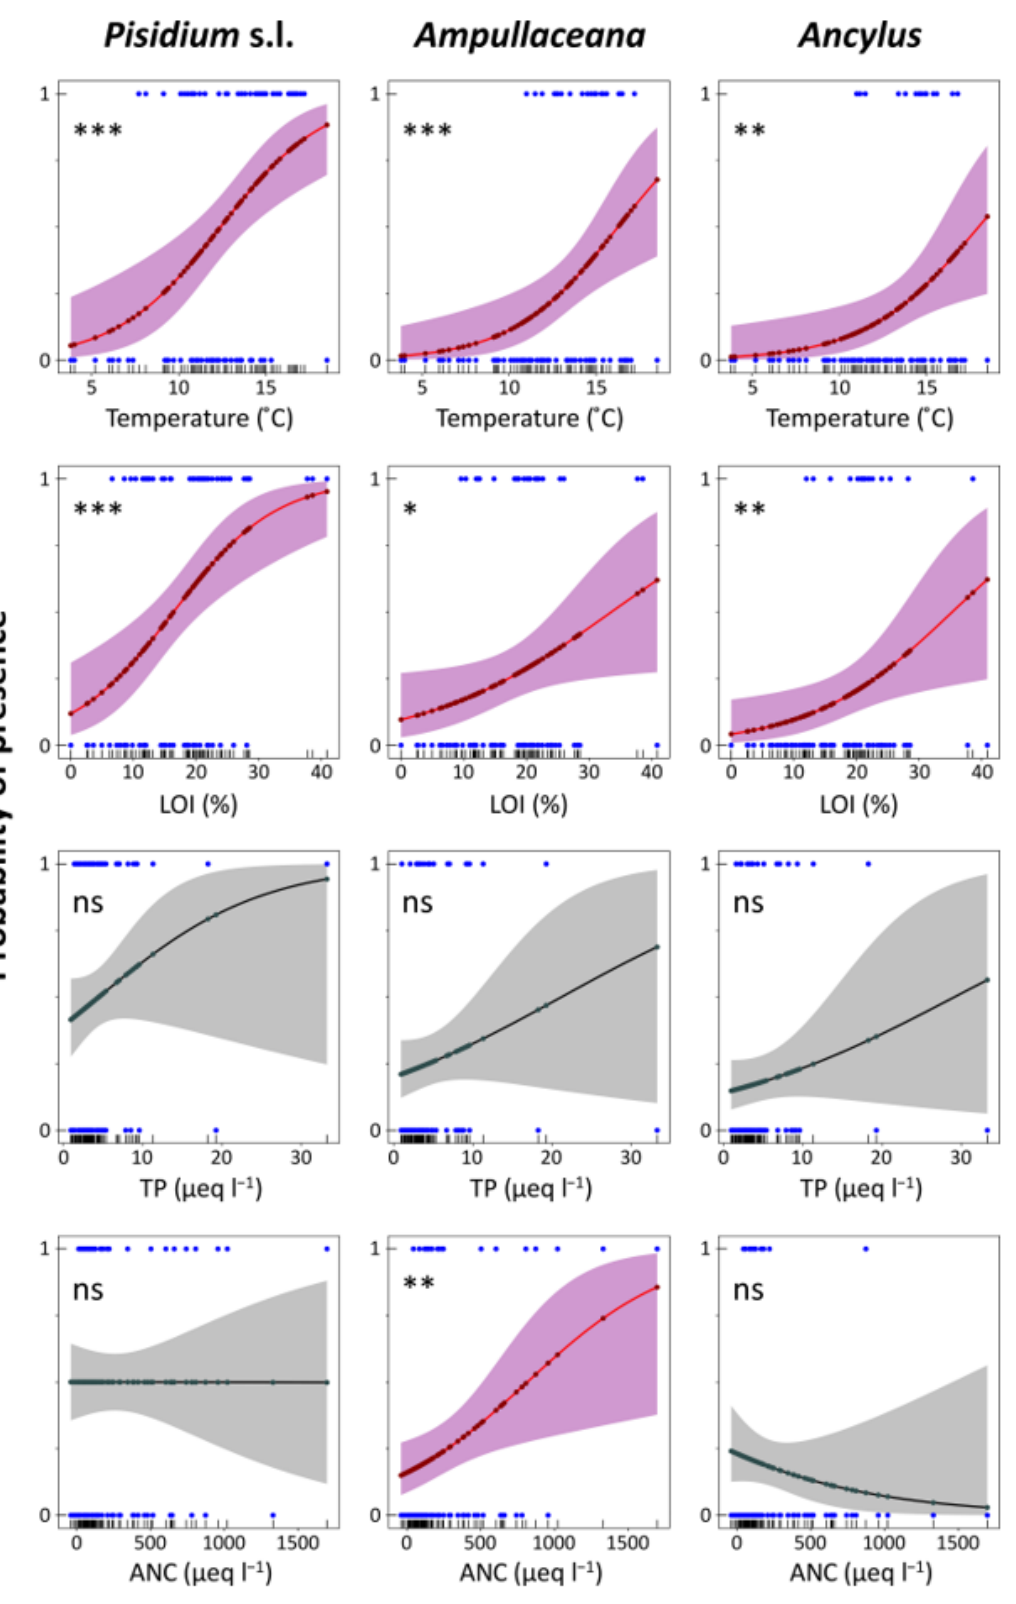
Figure 6. Logistic regression models for Pisidium s.l., Ampullaceana balthica , and Ancylus fluviatilis concerning temperature, organic content in sediments (LOI), total phosphorus (TP), and acid neu- tralizing capacity (ANC). Level of significance follows a chi-square test on a deviance table: ns, not significant; *, p < 0.05; **, p < 0.01; ***, p < 0.001.